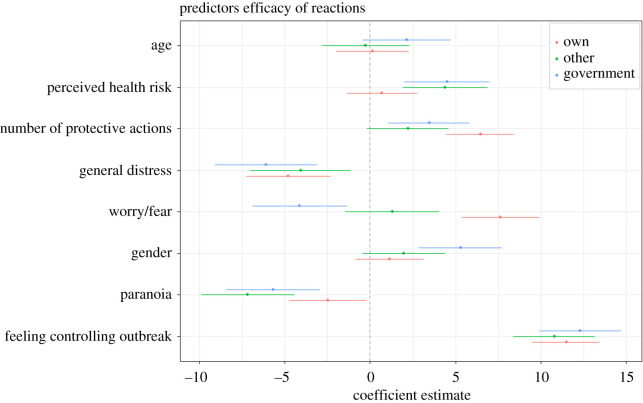
Coefficient estimates of the eight predictors for perceived efficacy of self, others' or governmental reaction, with 95% confidence interval. More worry/fear (fear appraisal) increases the efficacy of own reactions but had an opposite effect for rating the efficacy of governmental reactions.